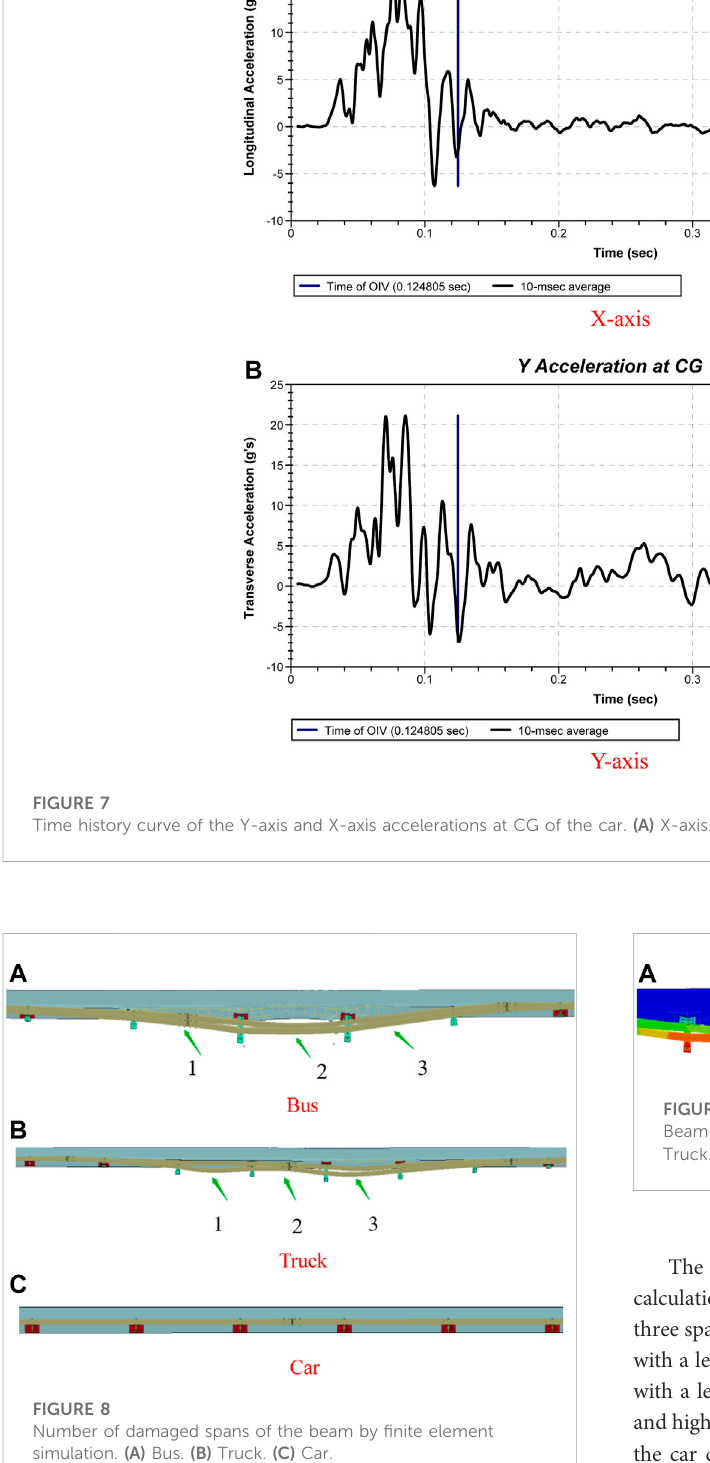
The top concrete failure length is 2.5 m by yield line theory calculation (Figure 10). The fi nite element simulation shows that three spans of the guardrail are damaged by the crash of the bus, with a length of 5 m; and three spans are damaged by the truck, with a length of only 3 m. The bus has a longer damage length and higher damage degree than the truck. The damaged spans by the car can be ignored. The crash test shows that the bus has damaged 6 m of the concrete guardrail, with three spans and four